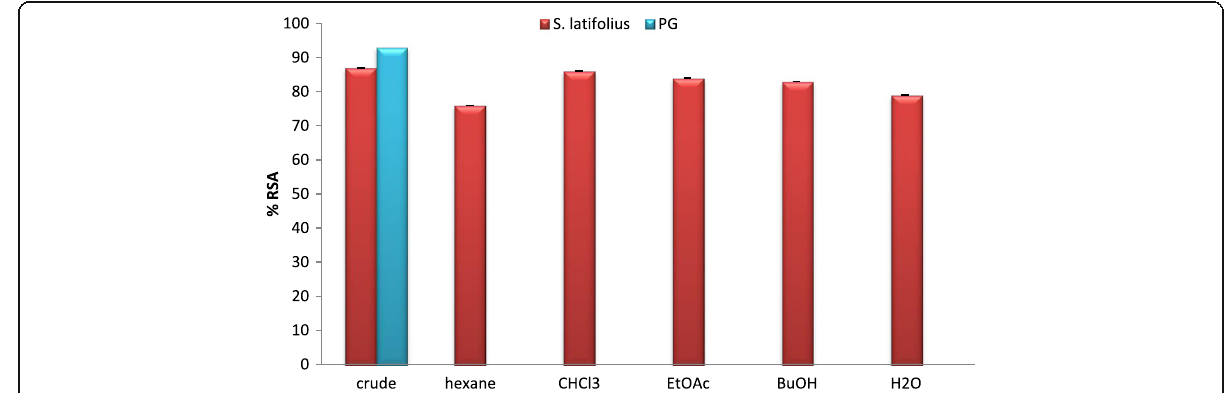
Fig. 3 Percentage of RSA of S. latifolius ehanolic extract and solvent fractions